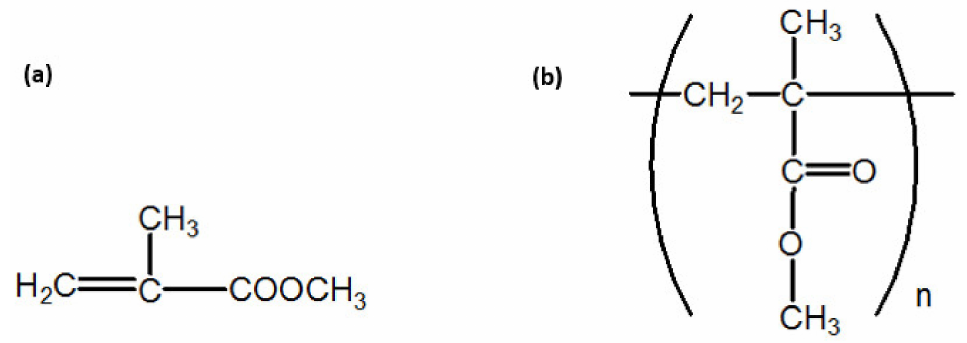
Figure 2. Structure of the MMA monomers ( a ) and the PMMA polymers ( b